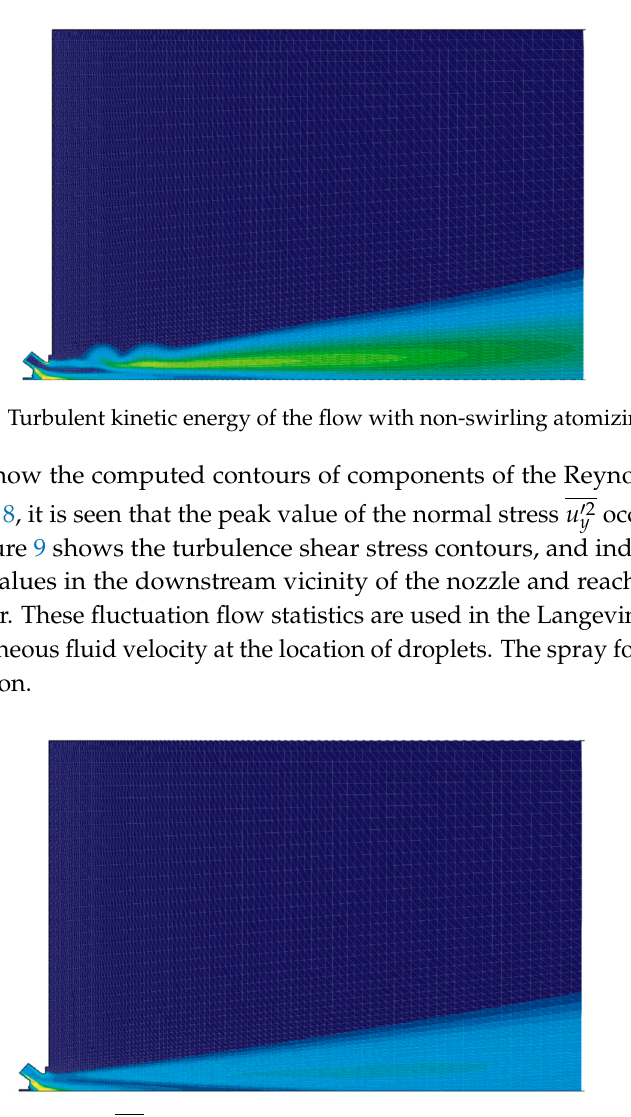
Figure 6. Streamwise velocity with non-swirling atomizing air.